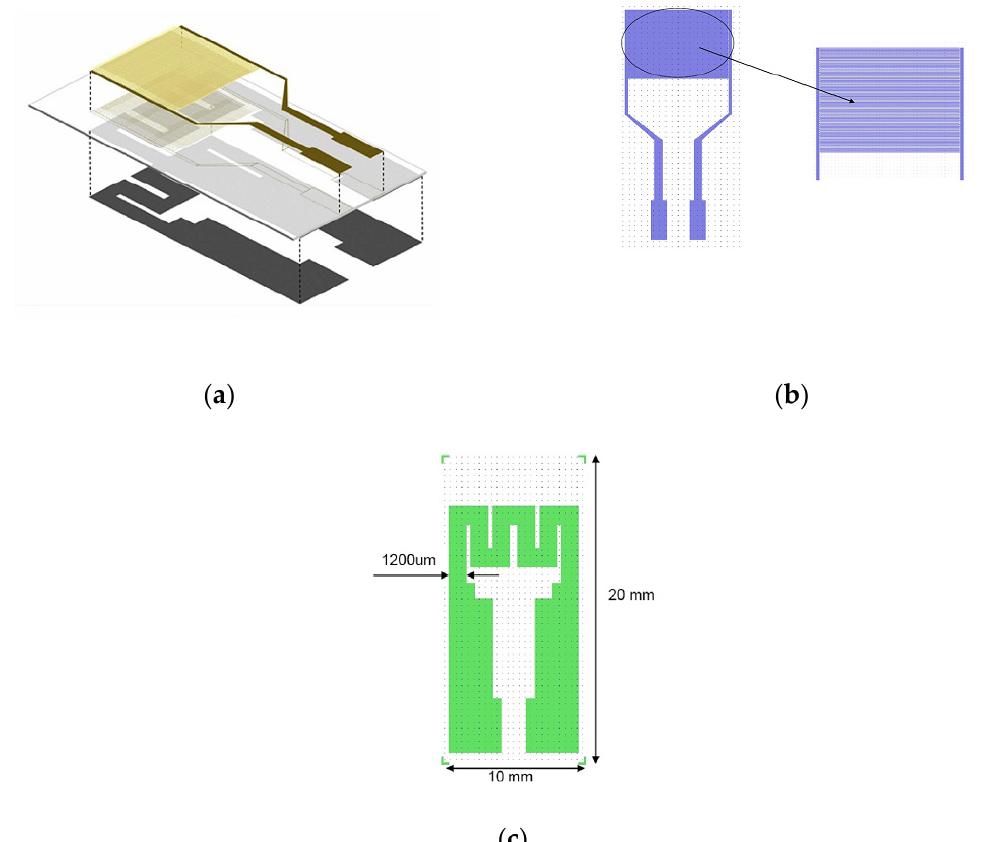
Figure 21. The alumina transducer schematic representation with ( a ) the overlay of the IDE and the heater; ( b ) gold IDE; and ( c ) platinum heater element, including the transducer dimensions of 10 × 20 × 0.2 mm, from Refs. [126,127].